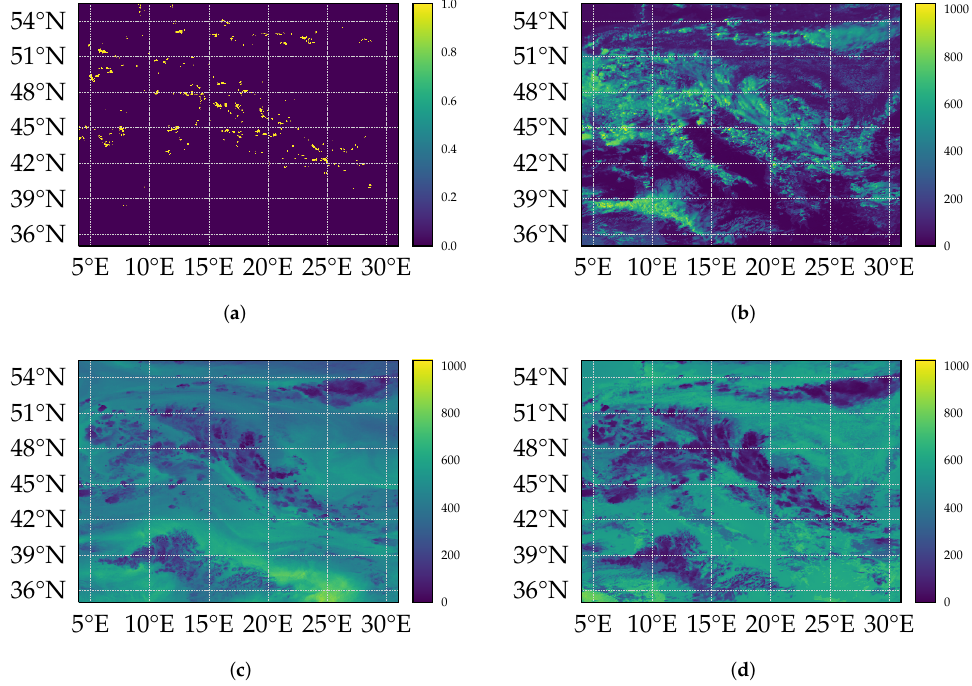
Figure 1. SEVIRI satellite images (in radiances) ( b – d ) and (aggregated and binarized) LINET events ( a ) for Central Europe on 4 June 2016 at 12:00 UTC. In the IR120 ( d ) (WV062, ( c )) only the cloud top contributes to the emission and hence to the signal measured at the satellite, with exception of semi-transparent clouds. However, in the VIS ( b ) the complete cloud contributes to the signal. The texture, thickness and shape of clouds are therefore much more pronounced in the